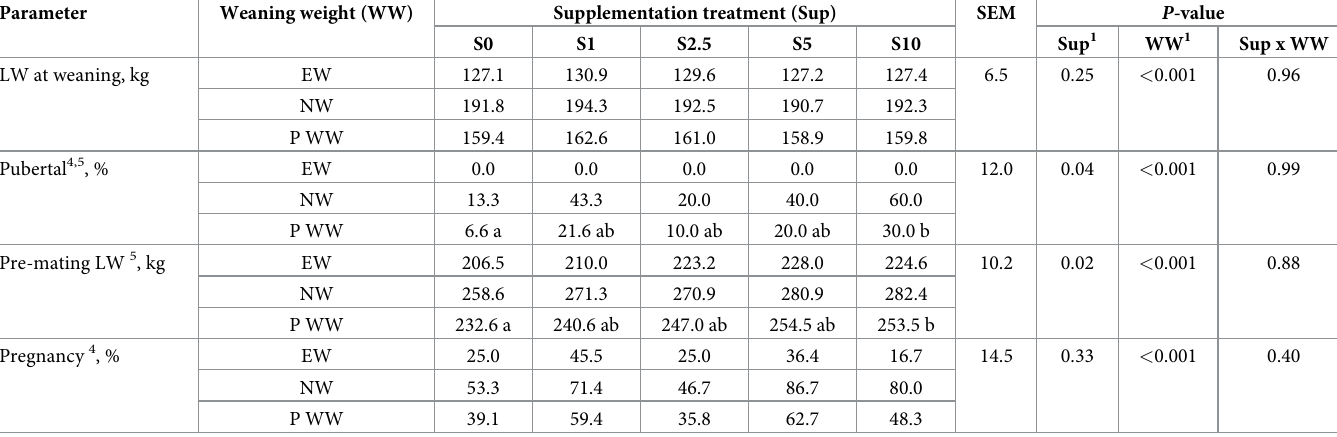
Table 5. Puberty and pregnancy percentage of early (EW) and normally (NW) weaned Brahman crossbred heifers fed different post-weaning supplementation treatments during the first dry season 1,2,3 . Parameter Weaning weight